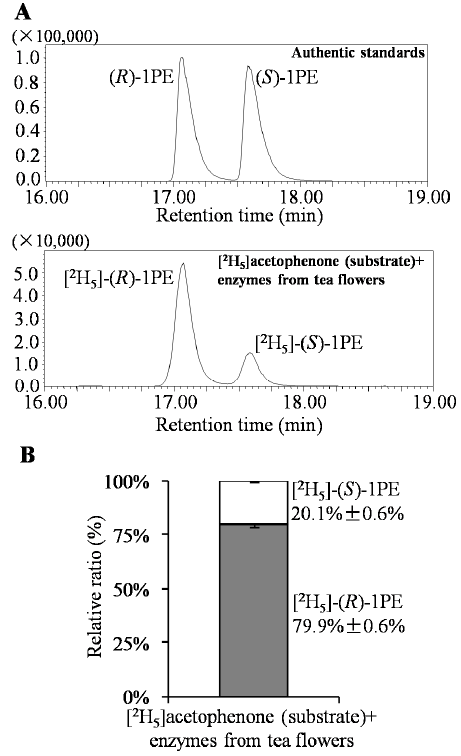
Figure 4. Identification of ( R )-1PE and ( S )-1PE from biotransformation using enzymes from tea flowers. ( A ) GC-MS equipped with an InertCap CHIRAMIX column was employed to determine ( R )-1PE and ( S )-1PE; ( B ) Data are expressed as mean ± S.D. ( n = 5).